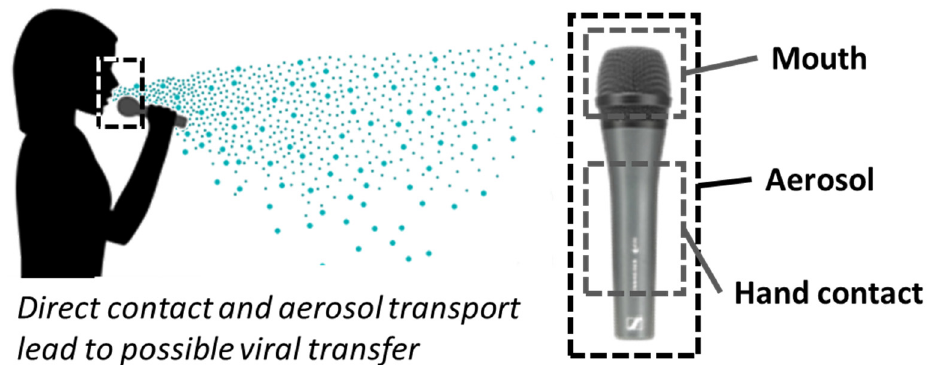
Figure 1. Representation of possible aerosol production during sound emission, and possible mi- crobial contamination of different parts of a microphone, which may lead to the transmission of pathogens upon shared use of the same device by different individuals.